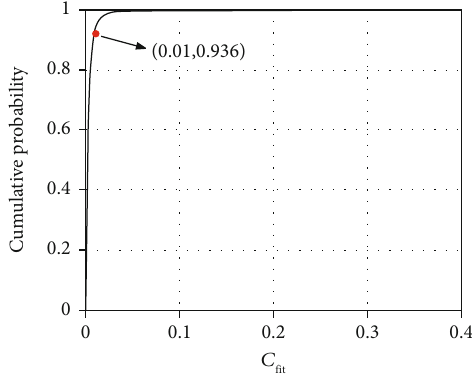
Figure 9: The relative errors of SIF calculated by discrete coe ffi cients and surrogate